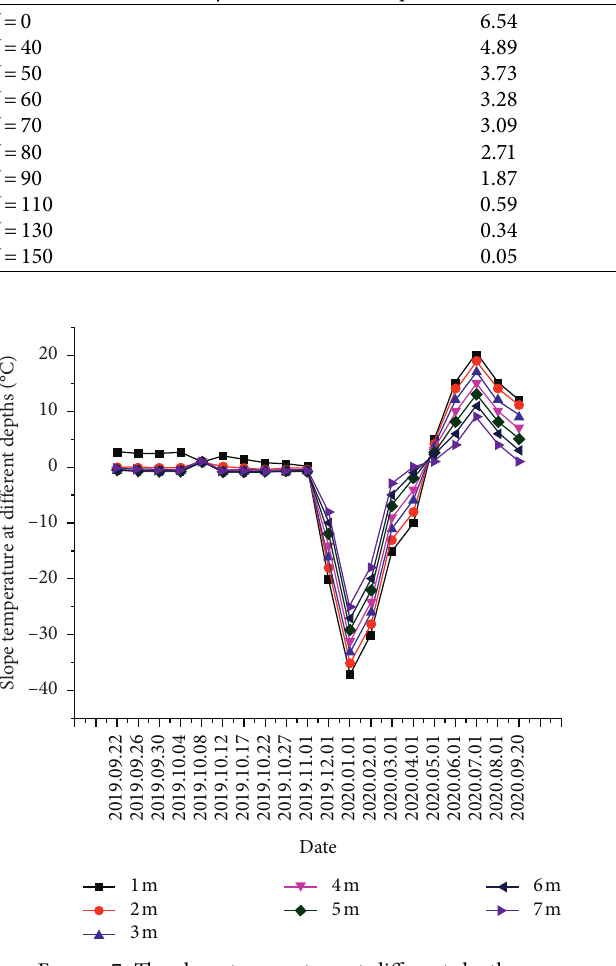
Figure 7: The slope temperature at different a horizontal distance 3 m from the slope top. Water sensors were installed vertically on the pit wall at intervals of 1 m, and the layout of the moisture sensor is shown in Figure 4(c).